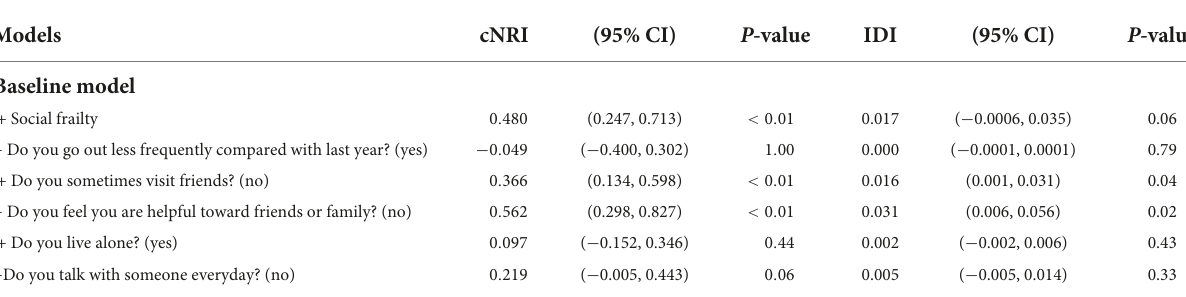
TABLE 3 Predictive ability for the composite